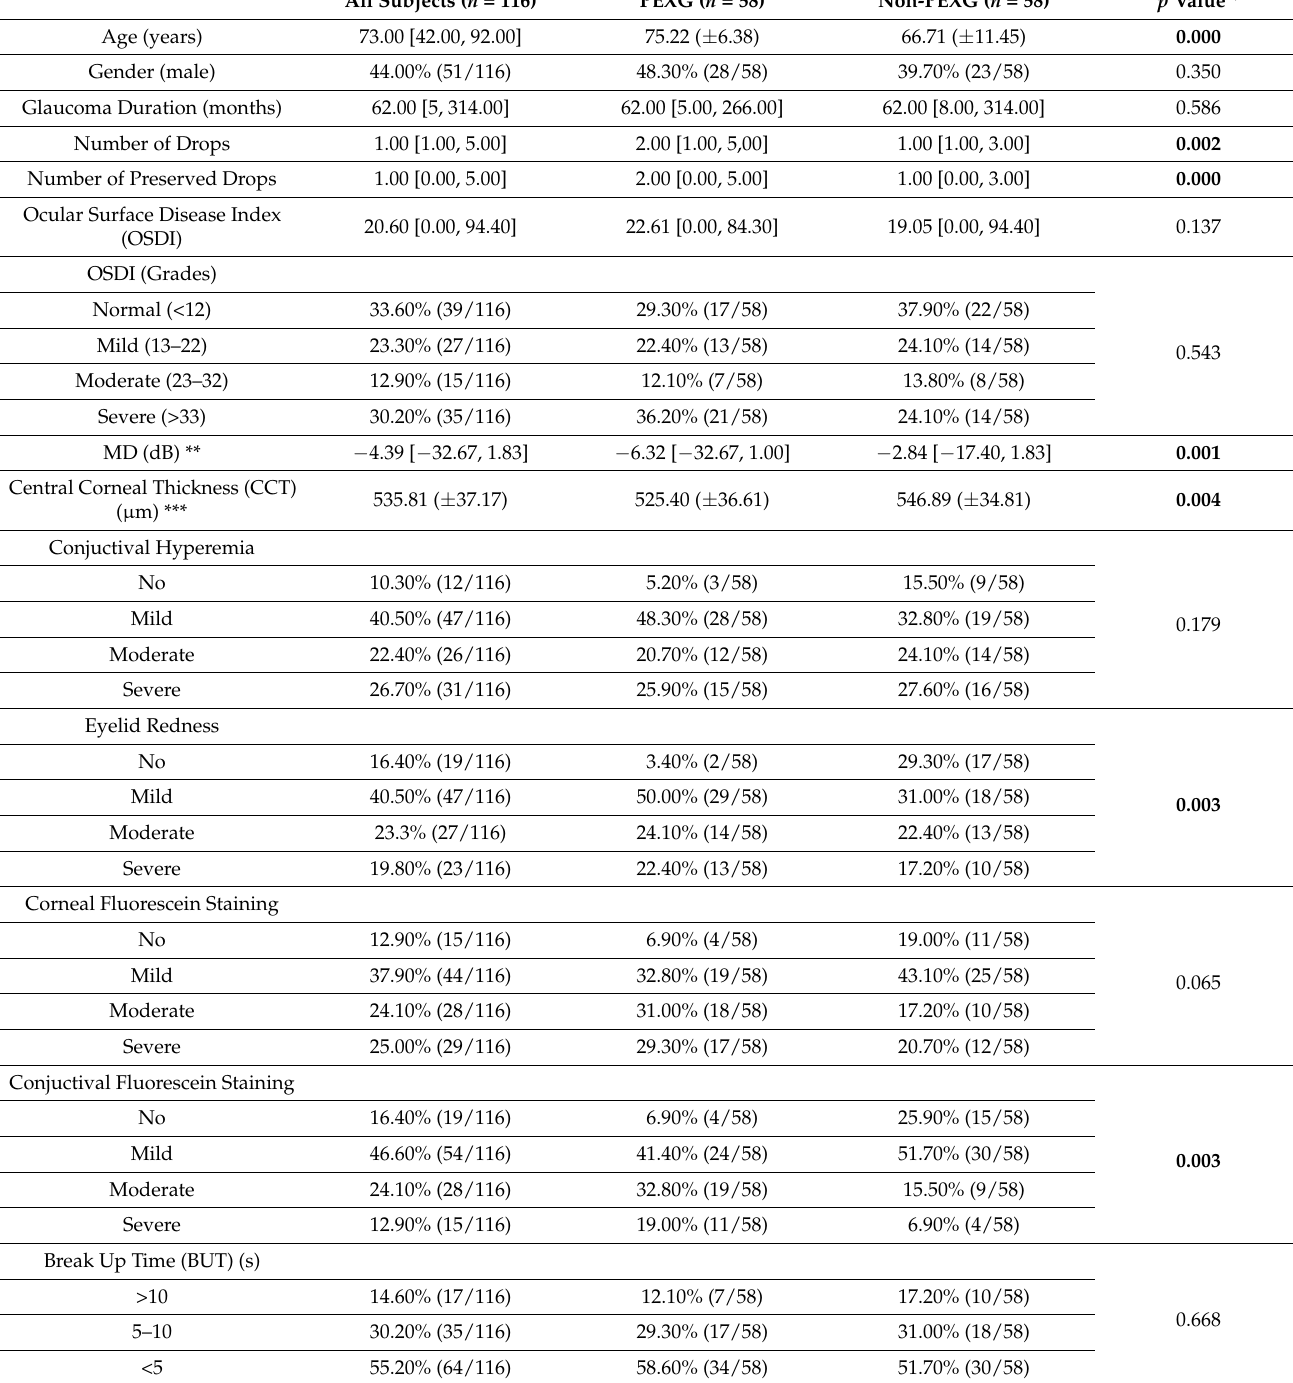
Table 1. Characteristics and ocular surface disease signs in subjects with pseudoexfoliative glaucoma (PEXG) and in Subjects with non-PEXG ( n =